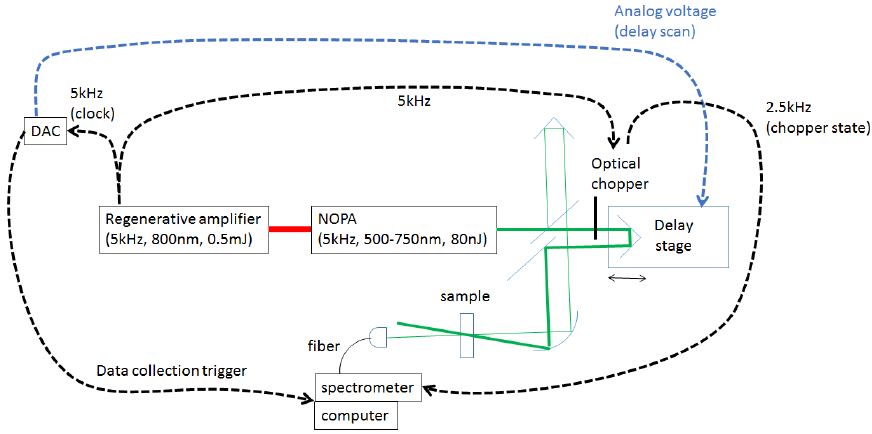
Figure 3. Schematic setup of the fastscan time-resolved absorption change spectroscopy system.